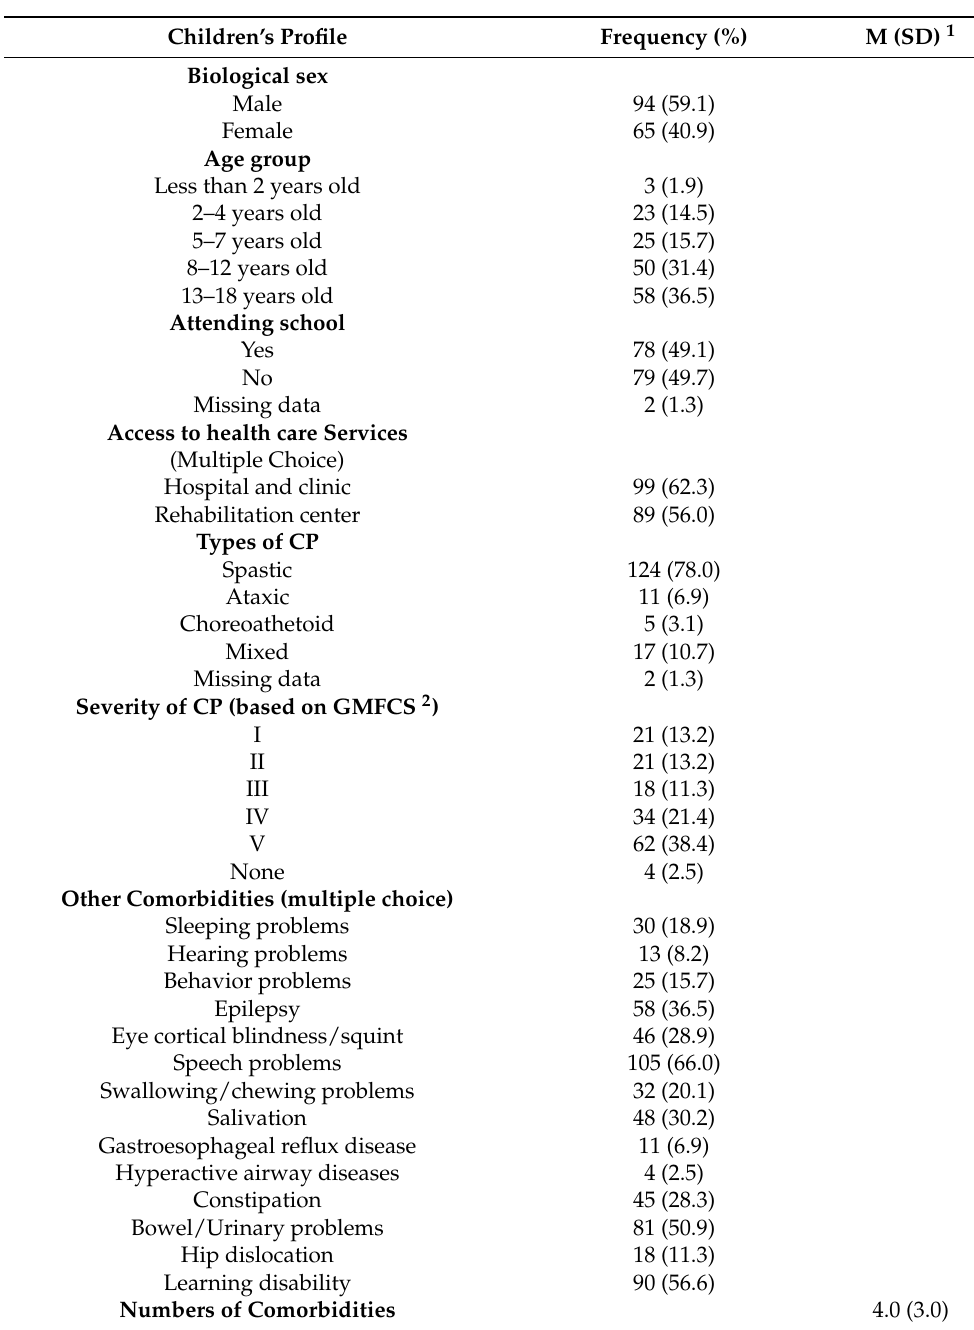
Table 2. Profile of the children with CP ( n =